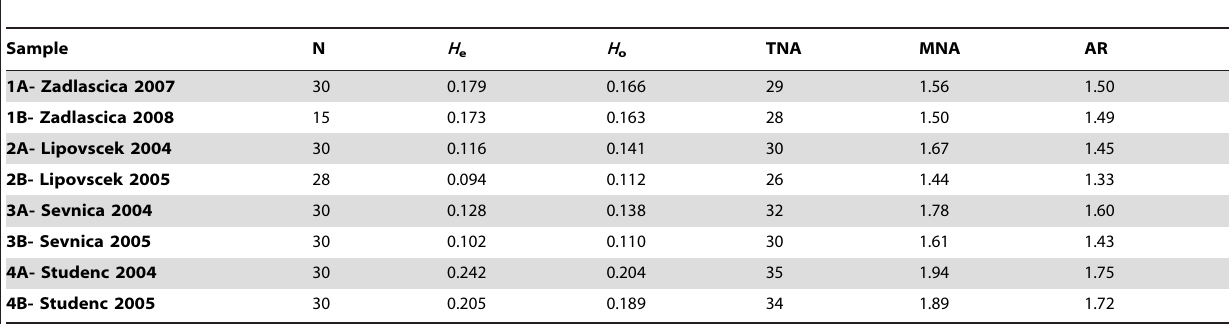
Table 3. Summary of genetic variability estimates across samples including number of individuals (N), expected ( H e ) and observed ( H o ) heterozygosities, total (TNA) and mean (MNA) number of alleles and allelic richness (AR).